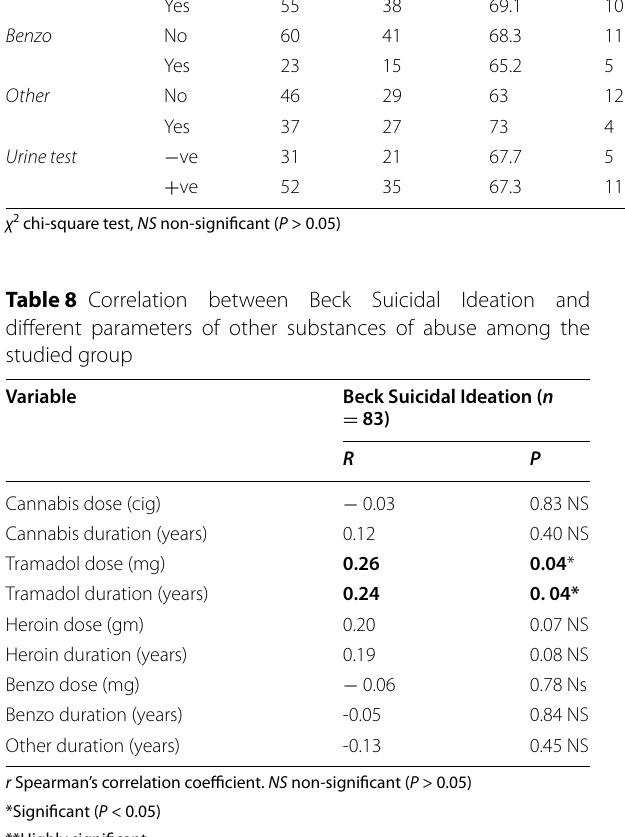
r Spearman’s correlation coefficient. NS non-significant ( P >